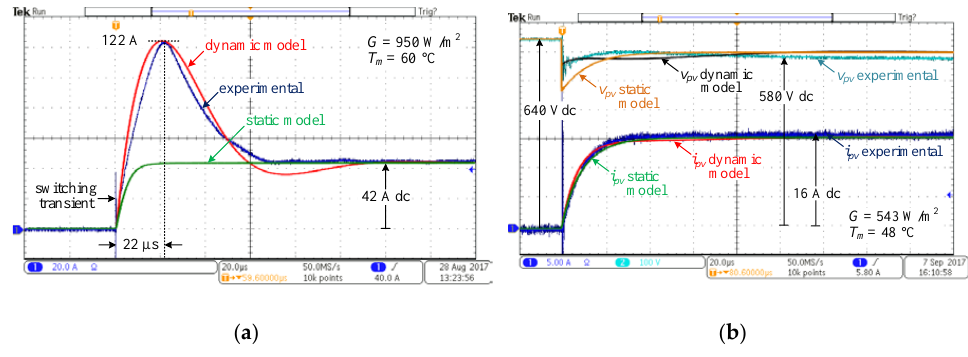
Figure 6. Transient response of the multi-string PV system at the input of the MPPT converter (Experimental: Tektronix MSO3034 oscilloscope, Tektronix TCPA300 current probe amplifier, Tektronix TCP404XL current probe; static model as given in Figure 5a; dynamic model as given in Figure 5b; Pyranometer EKO MS-410; Fluke Ti29 infrared camera): ( a ) from open-circuit to short-circuit; and ( b ) from open-circuit to partial resistive load ( R L = 42.5 Ω, L L = 278 μH measured by GW INSTEK LCR-817 LCR meter at the resistor temperature of 72 °C).